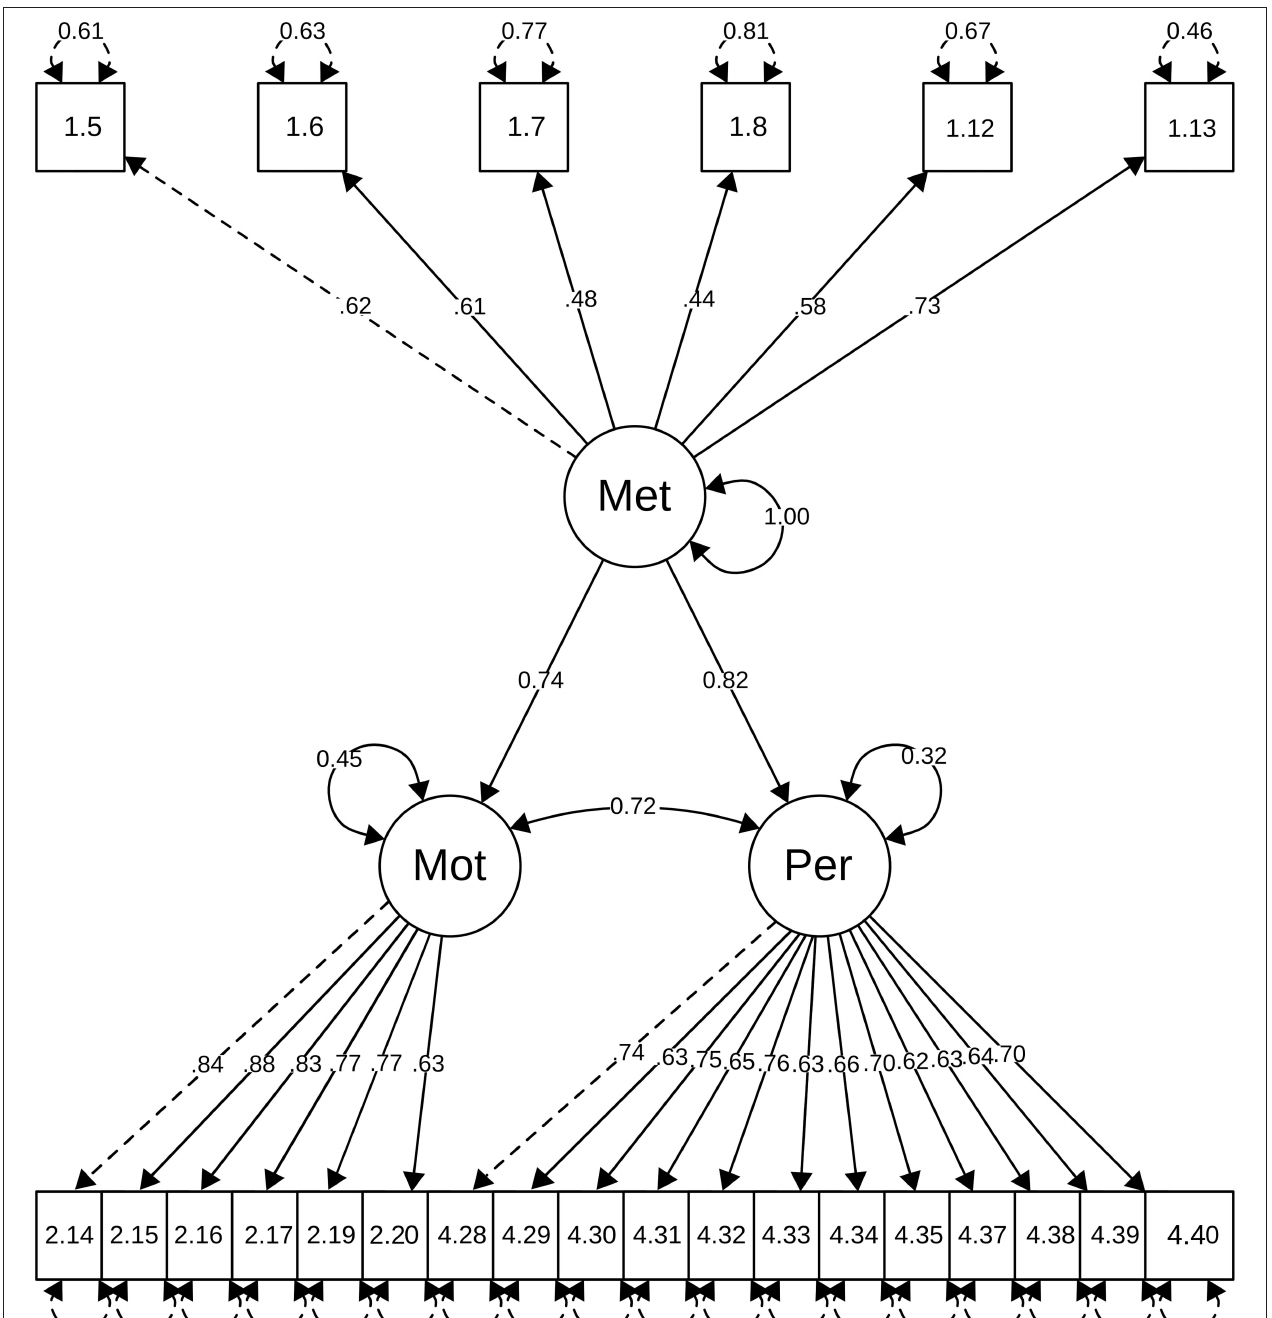
FIGURE 1 | Structural model